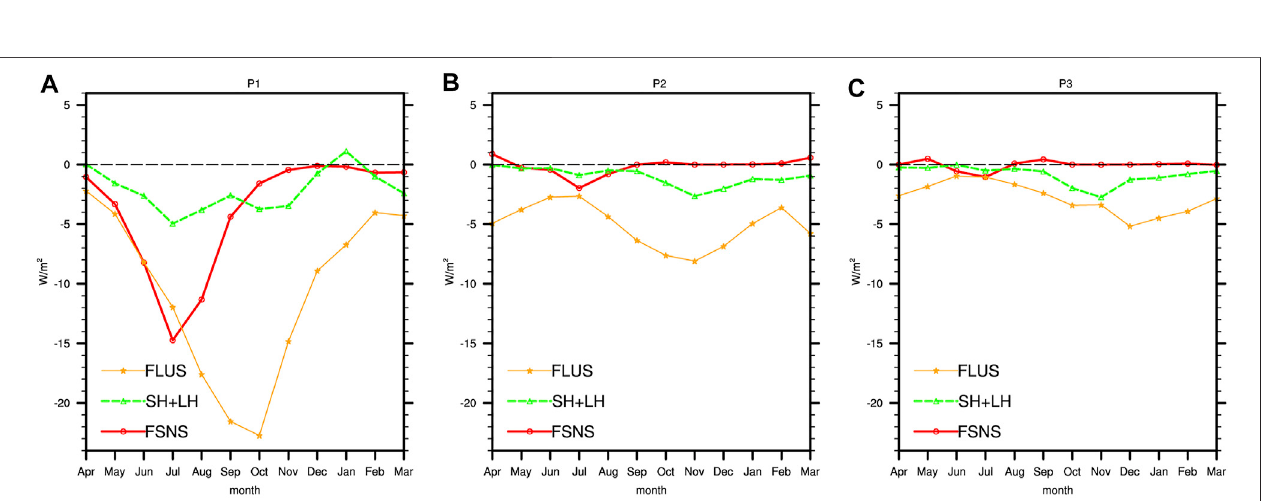
FIGURE 8 | Annual cycle of the anomalies of the surface net shortwave fl ux (FSNS, positive downward, red), sensible plus latent heat fl ux (SH + LH, positive upward, green), and upward longwave fl ux (FLUS, positive upward, orange) over the Arctic during Period-1 (A) , Period-2 (B) and Period-3 (C) after the Samalas mega volcanic